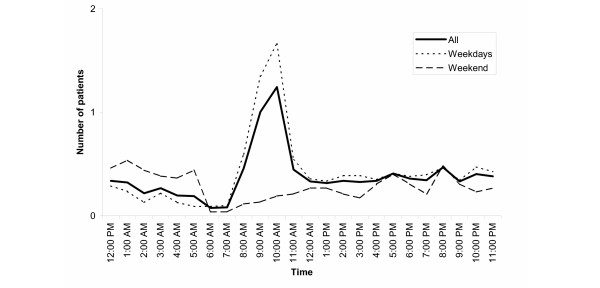
Flow of average number of patients during course of the day by time during the weekdays and at weekends. Note 1: based on 1,696 patients (52 missing) for whom the exact time of attendance was available